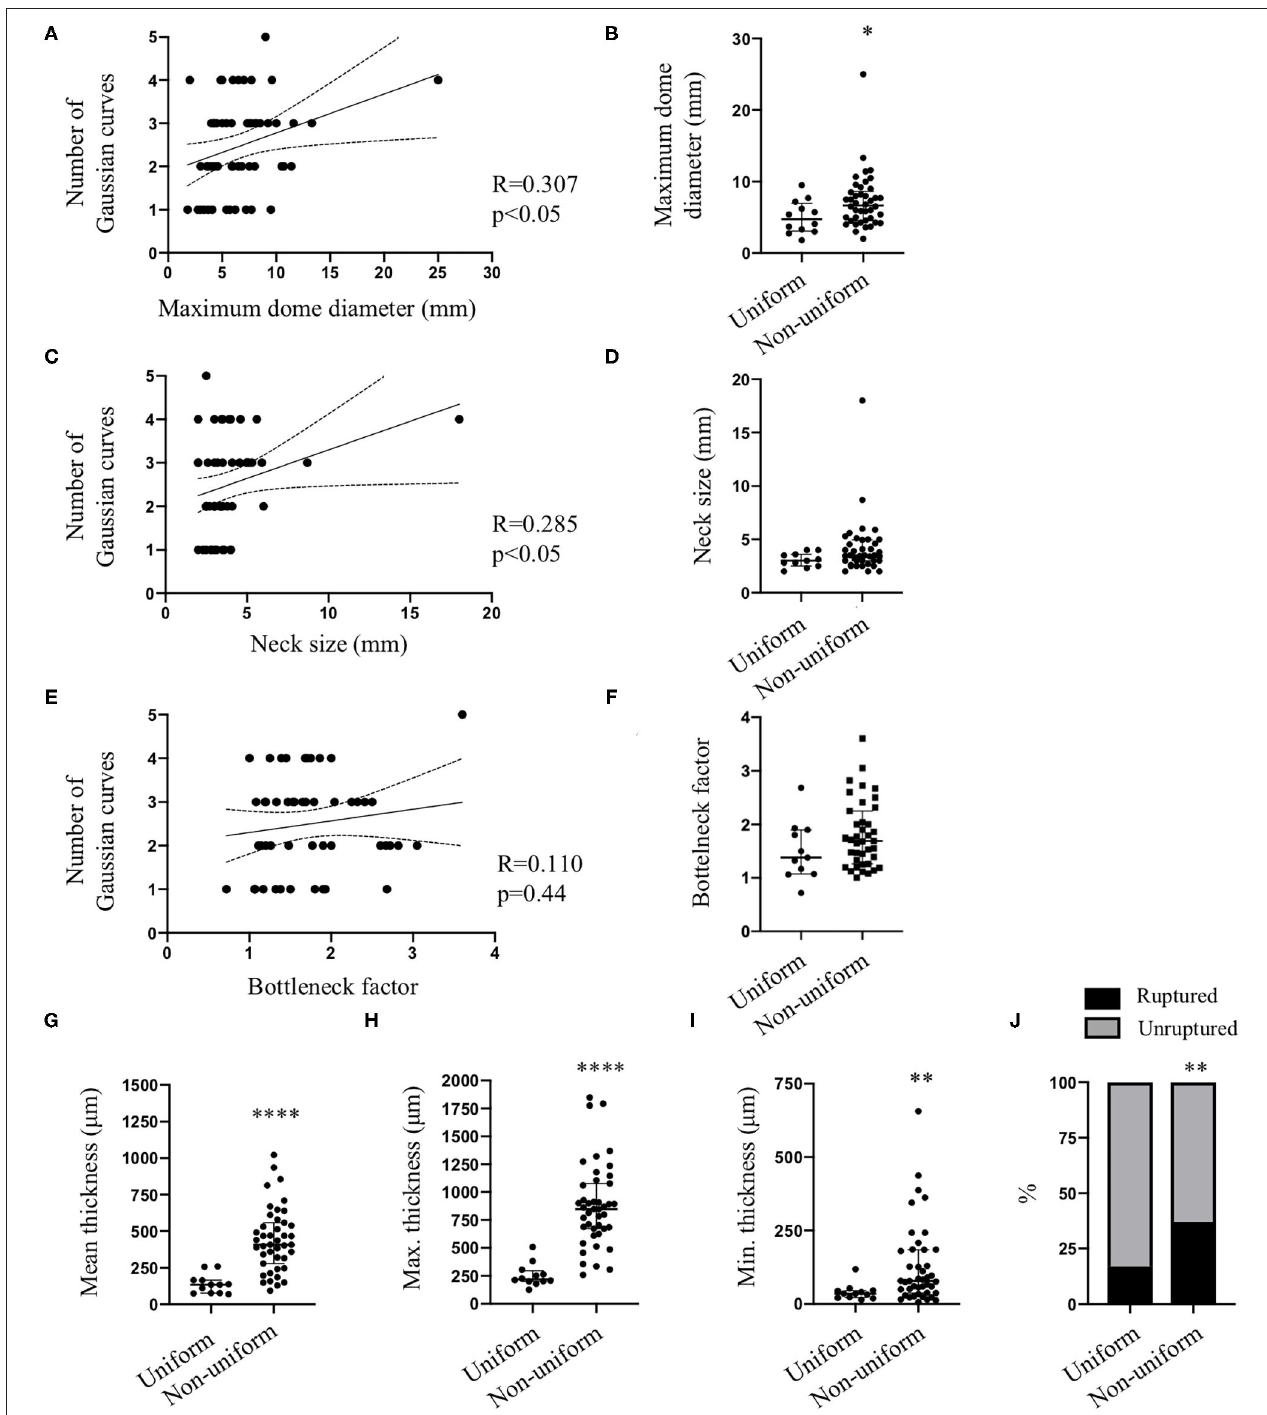
FIGURE 5 | Intracranial aneurysm characteristics and wall uniformity. Spearman correlations between maximum dome diameter (A) , neck size (C) or bottleneck factor (E) and number of Gaussian curves characterizing each intracranial aneurysm. Maximum dome diameter (B) , neck size (D) , and bottleneck factor (F) values in groups having a uniform or non-uniform IA wall thickness. Mean (G) , maximum [Max. (H) ] and minimum [Min. (I) ] wall thickness in groups having a uniform or non-uniform IA wall thickness. Data are shown as individual values and as median with interquartile range. * p < 0.05, ** p < 0.01, **** p < 0.0001, non-parametric Mann-Whitney U -test. (J) Distribution of ruptured (black) and unruptured (gray) IA domes between uniform and non-uniform wall thickness groups. ** p < 0.01, Fisher’s exact test.